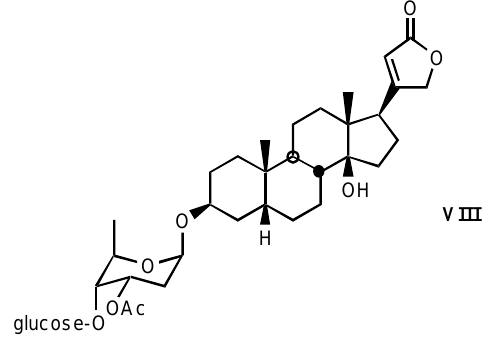
Figure 4. Structure of digitoxigenin-3- O - b -glucosyl-(1->4)-3’- O -acetyl- b - D -digitoxoside ( VIII